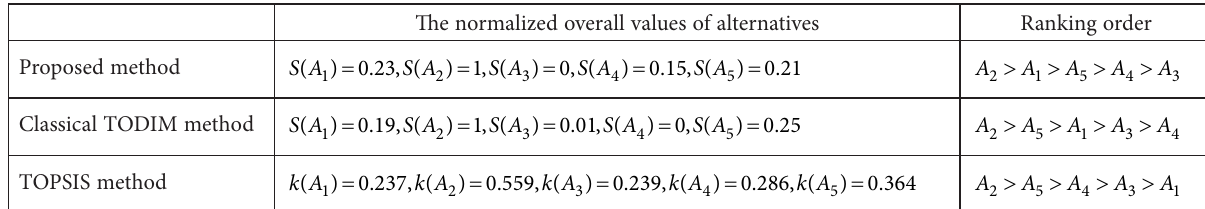
Table 5. The ranking order of alternatives with different